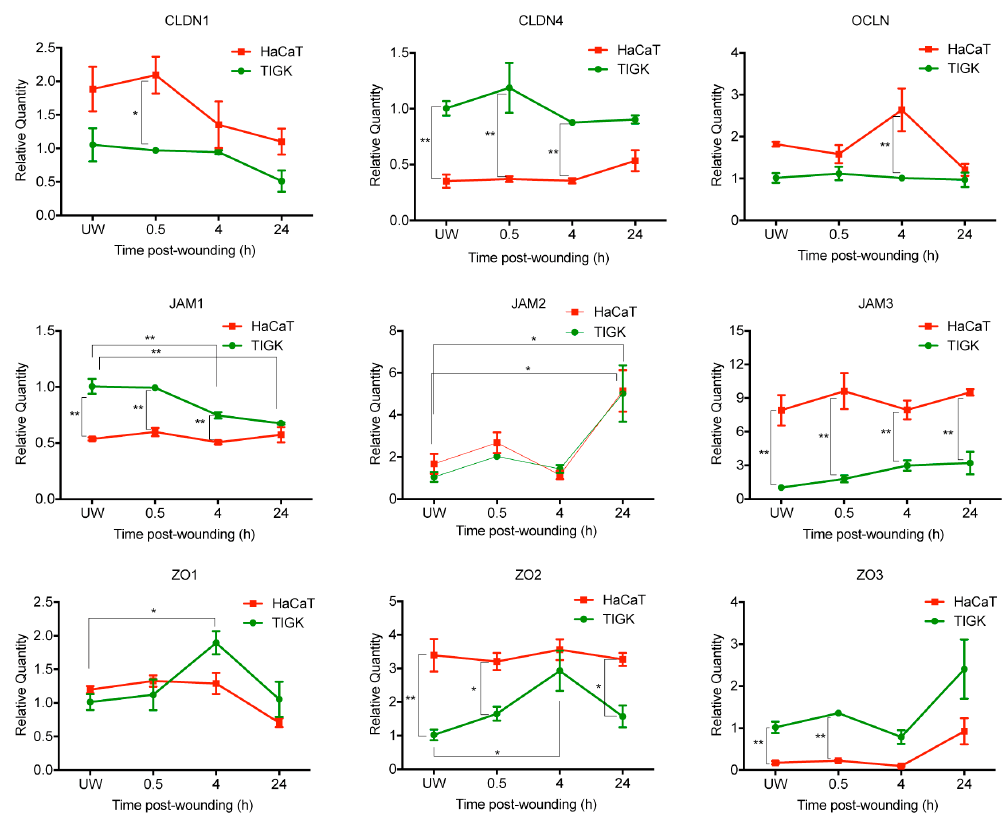
Figure 3. Differential expression of tight junction molecules after injury in skin and oral keratinocytes. Immortalized human skin keratinocyte (HaCaT) and human gingival keratinocyte (TIGK) cells were cultured in a 12-well culture plate. When the cells were confluent, three horizontal and three vertical scratch wounds were made. mRNA expression of claudin (CLDN) CLDN1, CLDN4 , occludin (OCLN) , junctional adhesion molecule (JAM) JAM1, JAM2, JAM3 , zonula occludens (ZO) ZO1, ZO2, and ZO3 were examined 0.5, 4, and 24 hours (h) after wounding by real-time PCR. UW: unwounded. n = 3 replicates, * p < 0.05, ** p < 0.01.